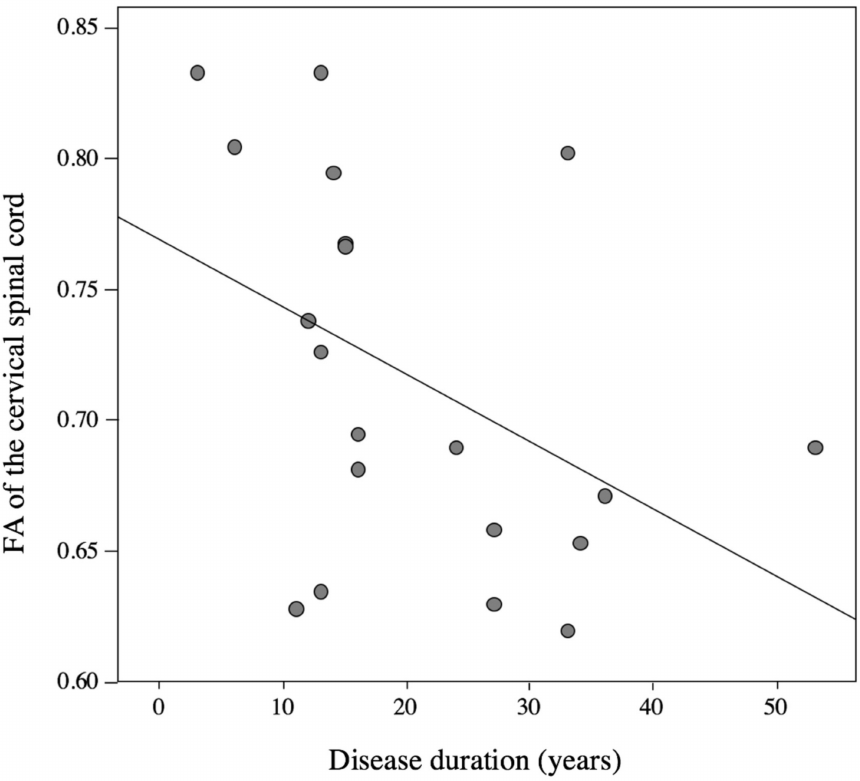
Figure 5. Correlation between FA of the cervical cord and disease duration. FA of the cervical cord correlates significantly with disease duration of pHSP patients ( r = − 0.457, p <